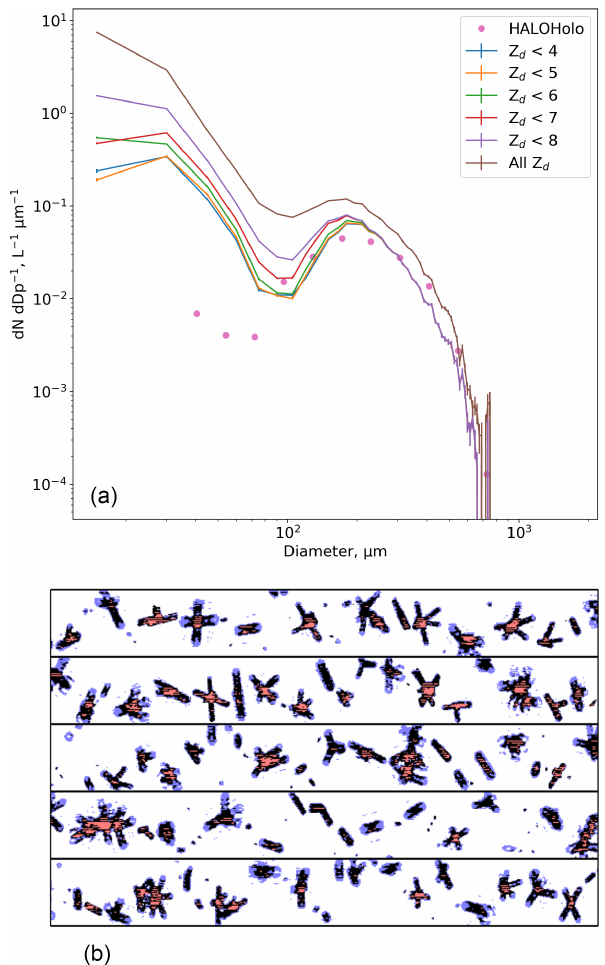
Figure 11. (a) Size distributions for a straight and level run at − 42 ◦ C in cirrus (16:02:00 to 16:10:00, 7 February) from a holo- graphic imaging probe (pink markers) and the CIP-15 using differ- ent Z d thresholds. Panel (b) shows example CIP-15 images from this period. Decreases in detector intensity of 25% to 50%, 50% to 75% and >75% are shown as light blue, black and orange pix- els, respectively. Vertical lines show the Poisson counting uncer- tainty, which are very small for most of the size spectrum apart from >700µm, where they become